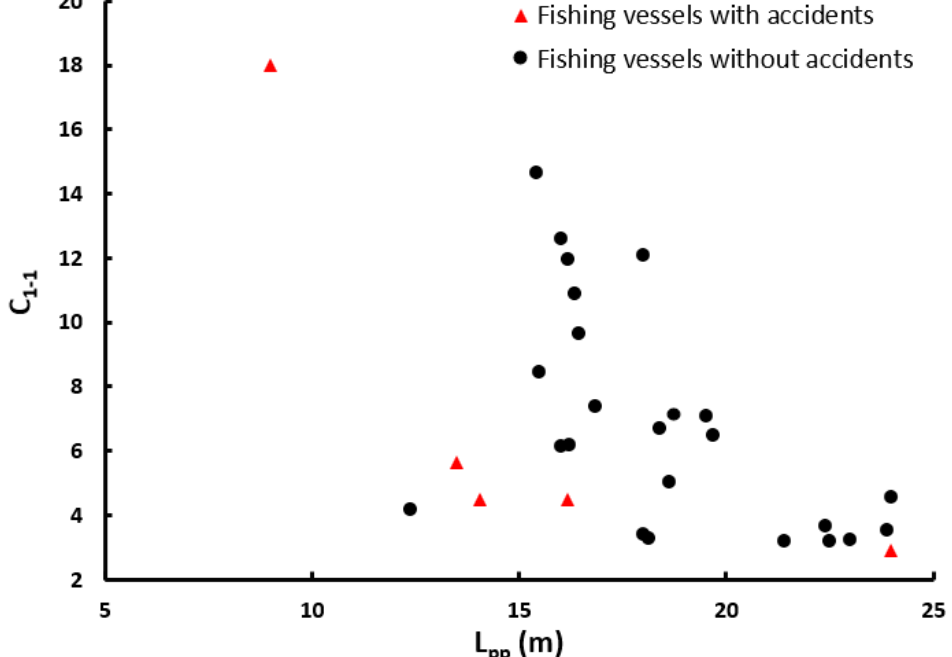
Figure 2. Fishing vessels with and without accidents in accordance with C 1–1 coefficient as a function of vessel length ( L pp ).